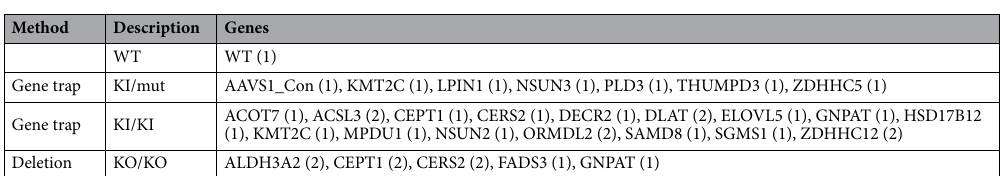
guideRNAs used, and validation data for each individual gene are listed in (Suppl. Table S01 and Table S02). As a control cell line, we inserted the trap cassette at the human safe-harbor locus Adeno-Associated Virus Integra- tion Site 1 (AAVS1). Knockout lines were grown in triplicates to a confluency of 20% and 80% (Fig. 1B), after which the lipidomes were analyzed. One or more independent knockout lines were successfully obtained for 23 genes resulting in a total of 36 clonal cell lines and 194 lipidomic measurements (Table 1).